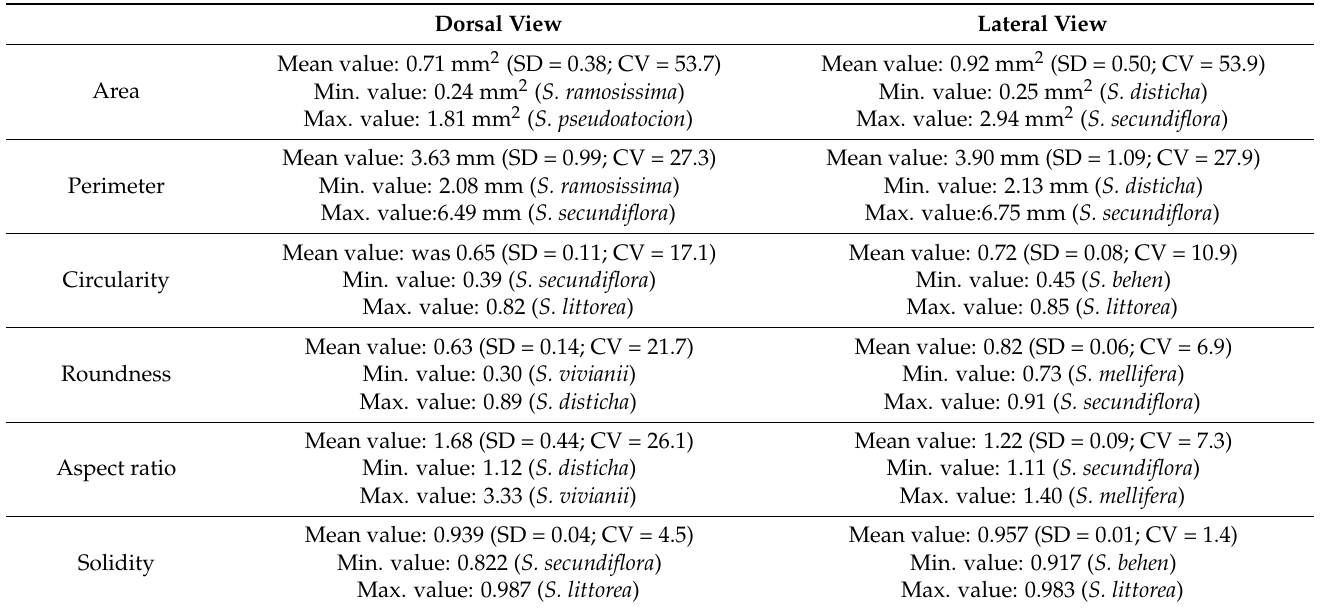
Table 1. Summary of the values obtained for the different geometric parameters from the seeds of Silene in this study. Dorsal View Lateral